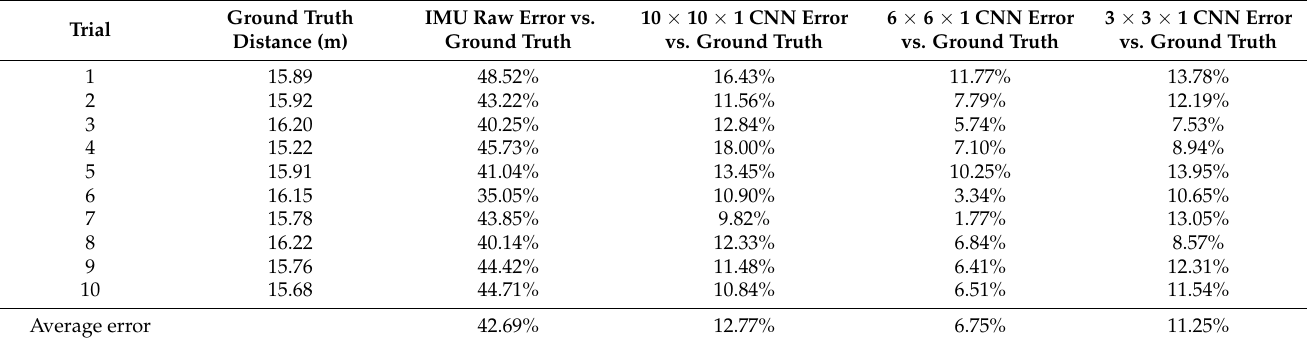
Table 9. Distance and percentage error results for TDK